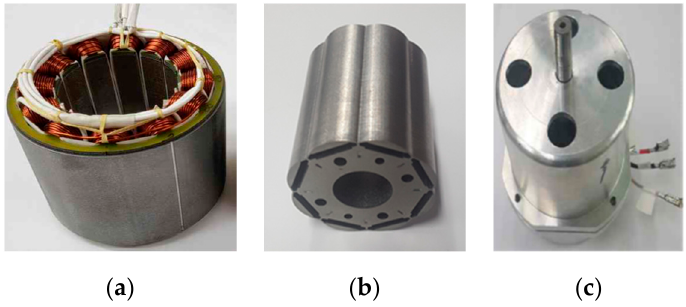
Figure 14. PMSM prototype for an electric compressor: ( a ) Stator; ( b ) rotor; ( c ) motor assembly.